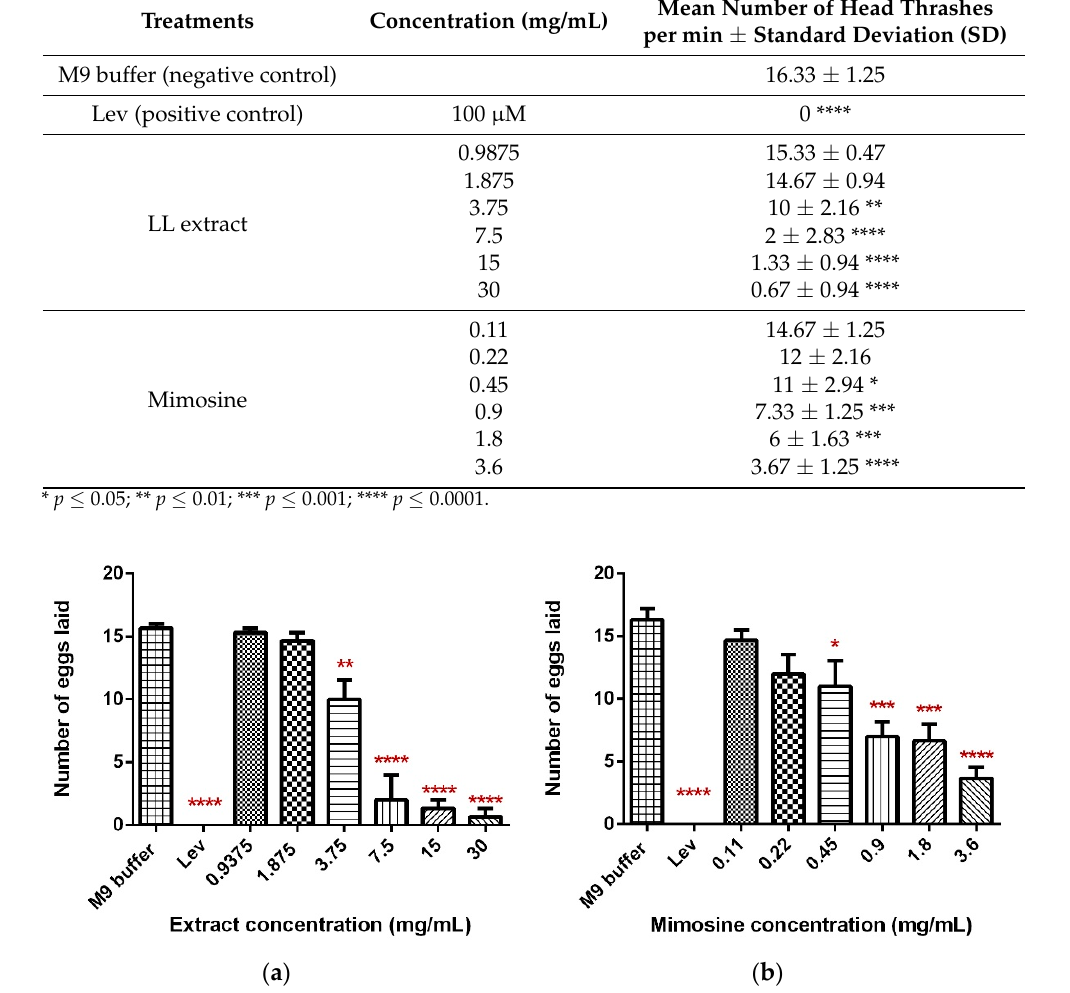
Figure 7. Effect of LL extract and mimosine on the egg-laying activity in C. elegans . ( a ) The number of eggs laid in LL extract. ( b ) The number of eggs laid per min in mimosine. Data are presented as means ± SD and are compared to M9 buffer as the negative control. Statistical significance was calculated using a one-way ANOVA with Dunnett’s multiple comparison test and is denoted by asterisks. * p ≤ 0.05; ** p ≤ 0.01; *** p ≤ 0.001; **** p ≤ 0.0001. n = 15 worms. Table 5. The egg-laying activity of LL extract and mimosine.